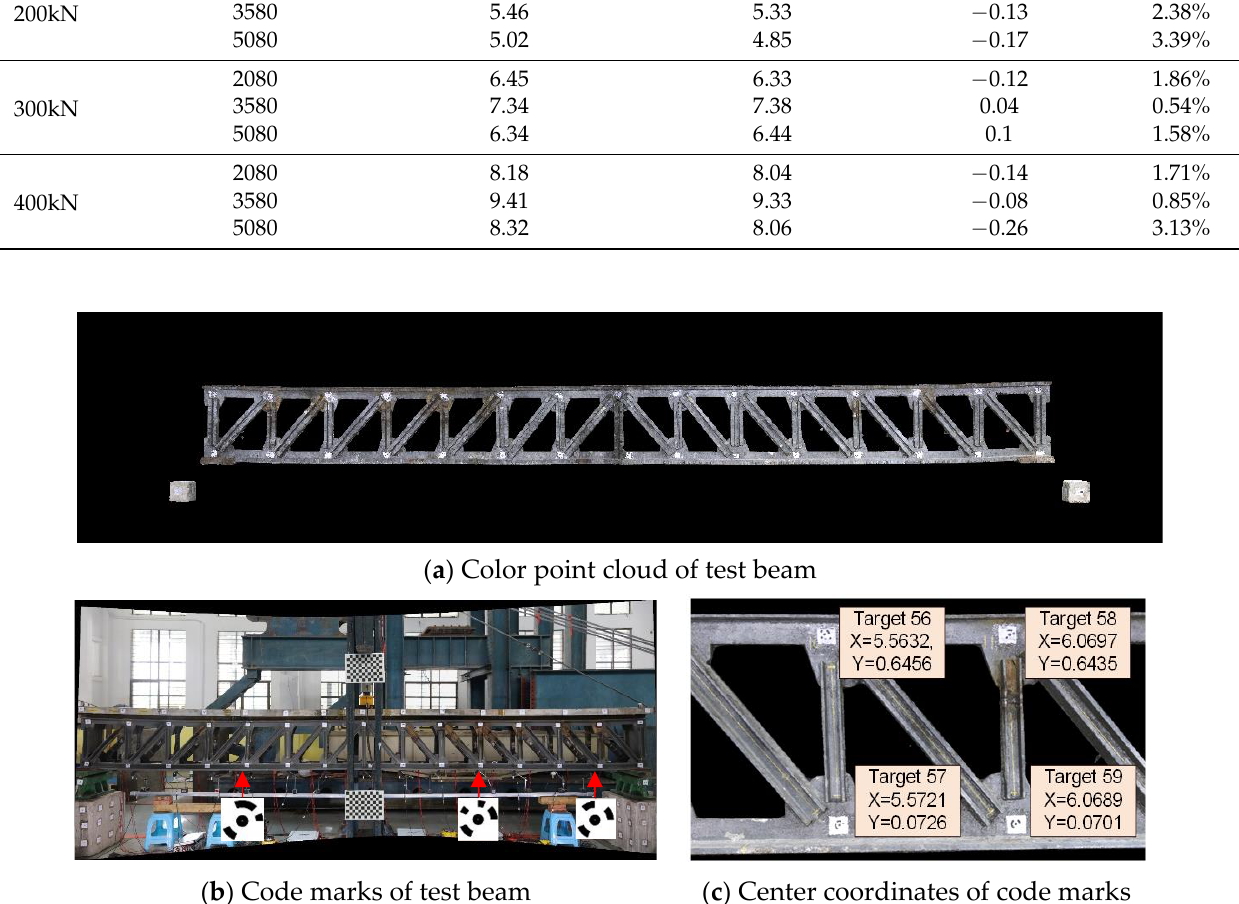
Figure 21. Location coordinate extraction of code marks. The same code-mark position coordinates were used before and after deformation for the displacement calculation. The code marks of the center displacement vector are shown in Figure 22 (based on the D01 400 kN condition).